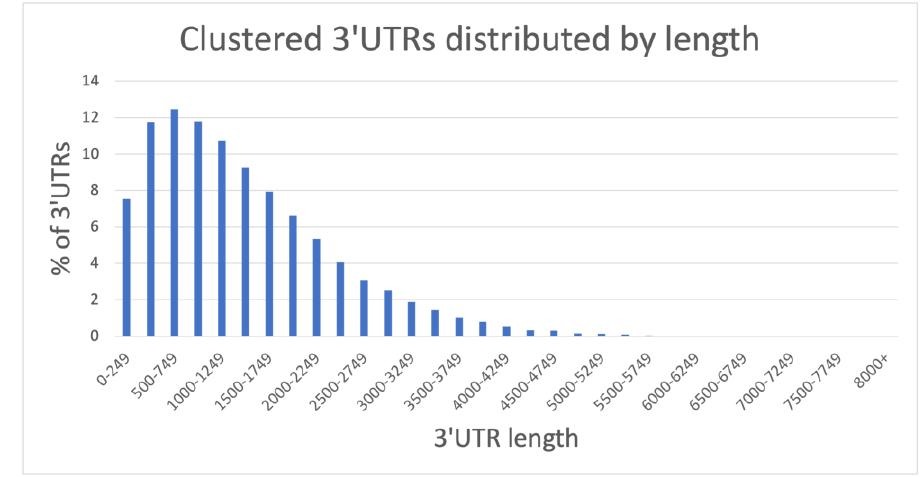
Figure 1. Distribution of 3’UTR lengths in the non - redundant 3’UTRome.